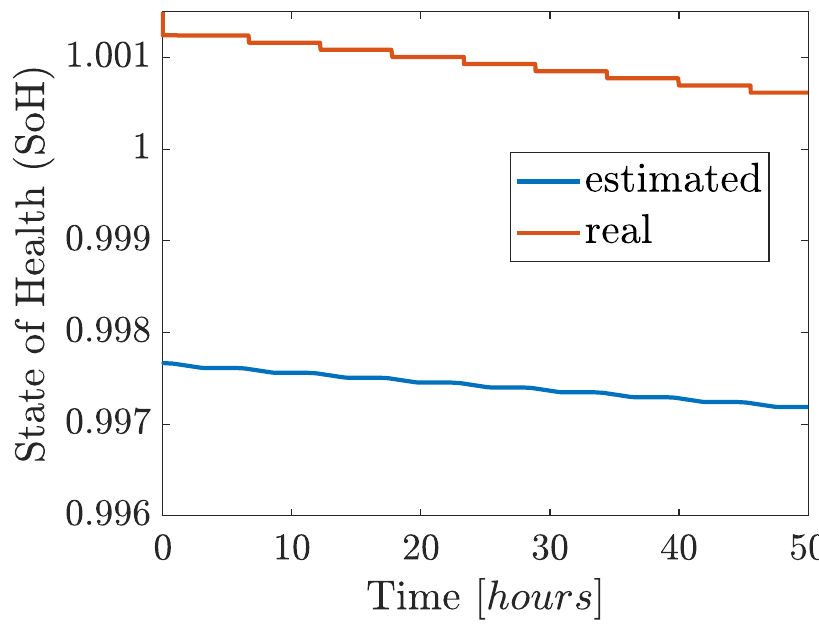
Figure 26. State of Health Estimation considering the SoH strategy. The control strategies analysed cannot correct errors due to the problems inherent to estimation. It would be necessary to insert a feedback loop to control eventual errors and deviations from estimations. This problem is especially critical for the SoH variable, since it is measured at a lower sampling rate than the SoC, which prolongs the action of the error. In the simulation, the estimated values ( SoC em , SoC e , SoH em , SoH e ) were different from the initial values that were provided by the battery model, to mimic the inaccuracy of the estimation values. While the SoC error was minimized during the simulation, the SoH error was